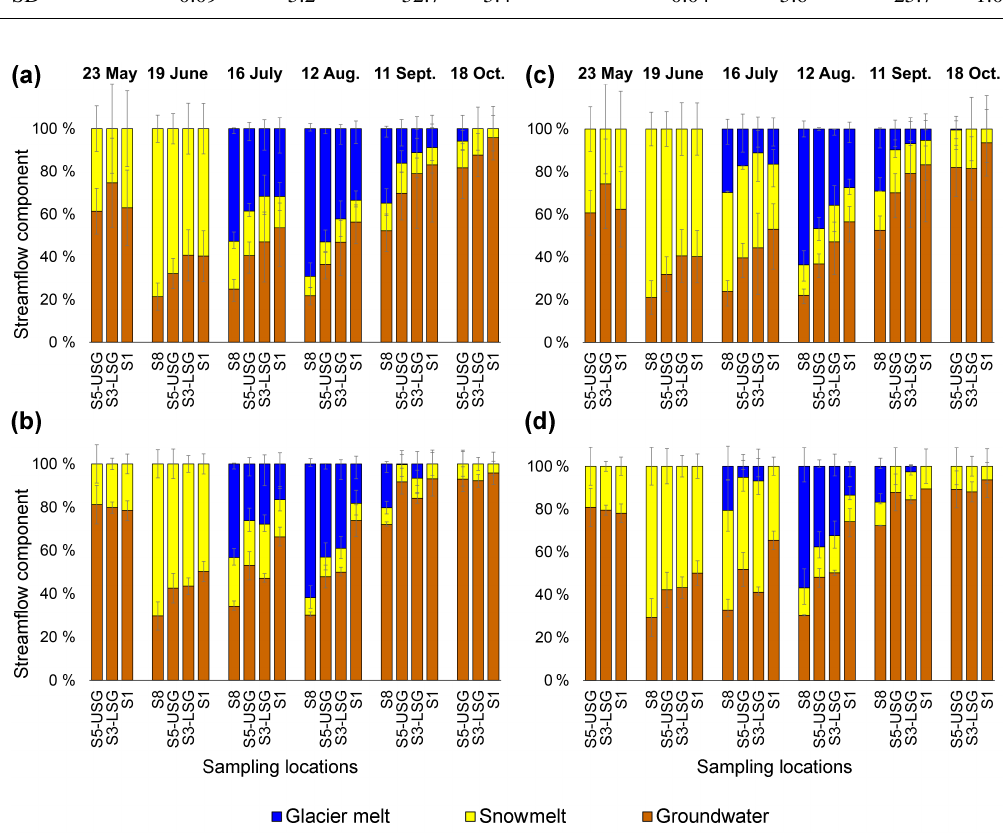
Figure 5. Fractions of groundwater, snowmelt and glacier melt in streamflow for the six sampling days in 2013 at four cross sections along the Saldur River. Left column panels: the isotopic composition and EC of the snowmelt end-member was considered time invariant, and the groundwater end-member was based on spring data (scenario A, a ) or on stream data (scenario B, b ). Right column panels: the isotopic composition of the snowmelt end-member was considered monthly variable, and the groundwater end-member was based on spring data (scenario C, c ) or on stream data (scenario D, d ) during baseflow conditions. The error bars represent the statistical uncertainty for each